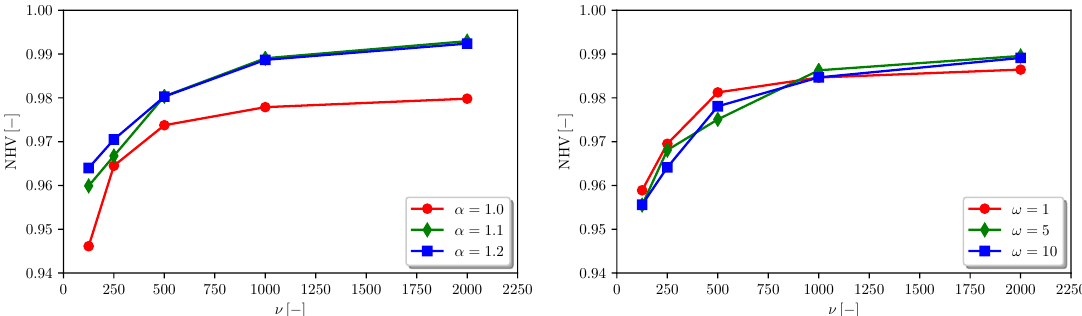
Figure 6. MODHA average performance for the analytical test problems, conditional to: the local search activation parameter α ( left ); and deepness parameter ω ( right ).